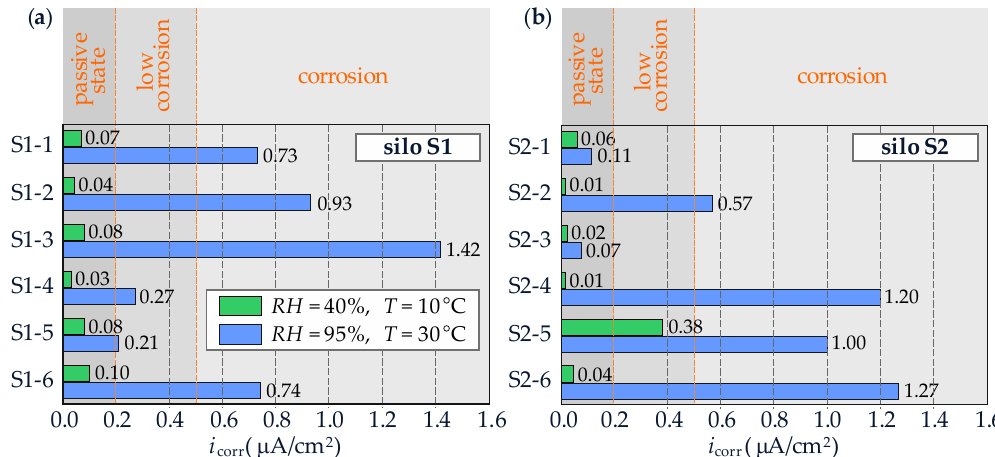
Figure 13. Distribution of corrosion current densities 𝑖 𝑐𝑜𝑟𝑟 presented as horizontal bar graphs, obtained for reinforcement of cylindrical concrete cores drilled from reinforced concrete silos for cement: ( a ) results for the silo S1; and ( b ) results for the silo S2; blue bars represent the tests at air temperature 𝑇 = 30 °C and relative humidity 𝑅𝐻 = 99%; green bars represent tests at air temperature 𝑇 = 30 °C and relative humidity 𝑅𝐻 = 99%; information in orange above the graphs show corrosion risk for reinforcement in concrete of the tested cores.